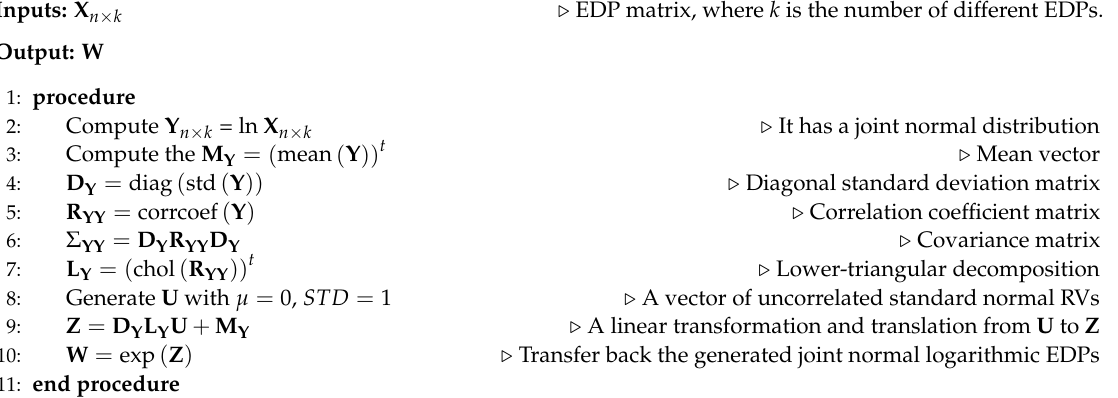
Algorithm 1 Generating correlated EDPs from initial finite number of